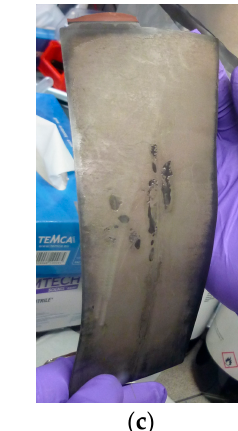
Figure 6. Post-mortem examination of a battery cell provided with a core Bragg grating inside the anode active material: ( a ) Shown is the separator side facing the anode material; ( b ) in the anode active material, the inserted light waveguide is recognizable; ( c ) on the backside of the anode material, lithium deposition traces can be detected as a result of the cathode over dimensioning applied.